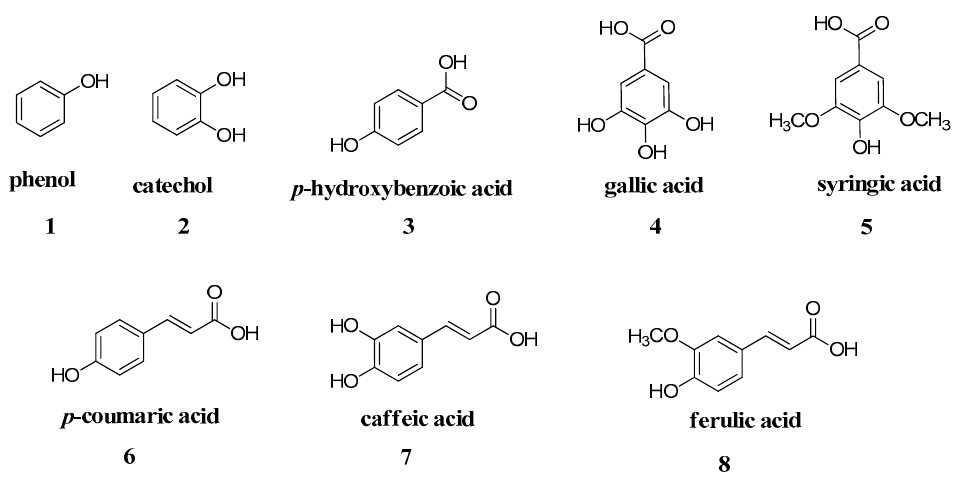
Figure 6. Some phenolic compounds as CAIs [45].